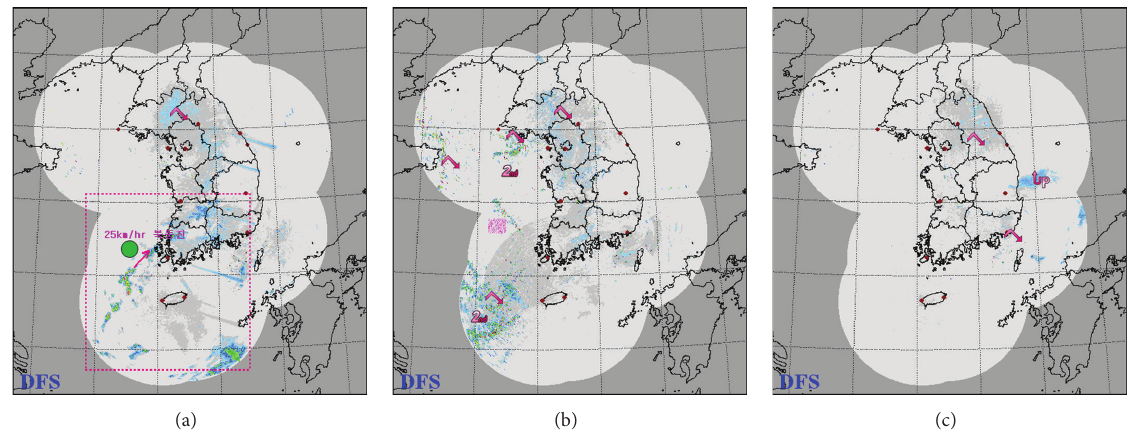
Figure 4: Anomalous propagation echo: (a) November 2, 2011, (b) March 28, 2012, and (c) April 14,